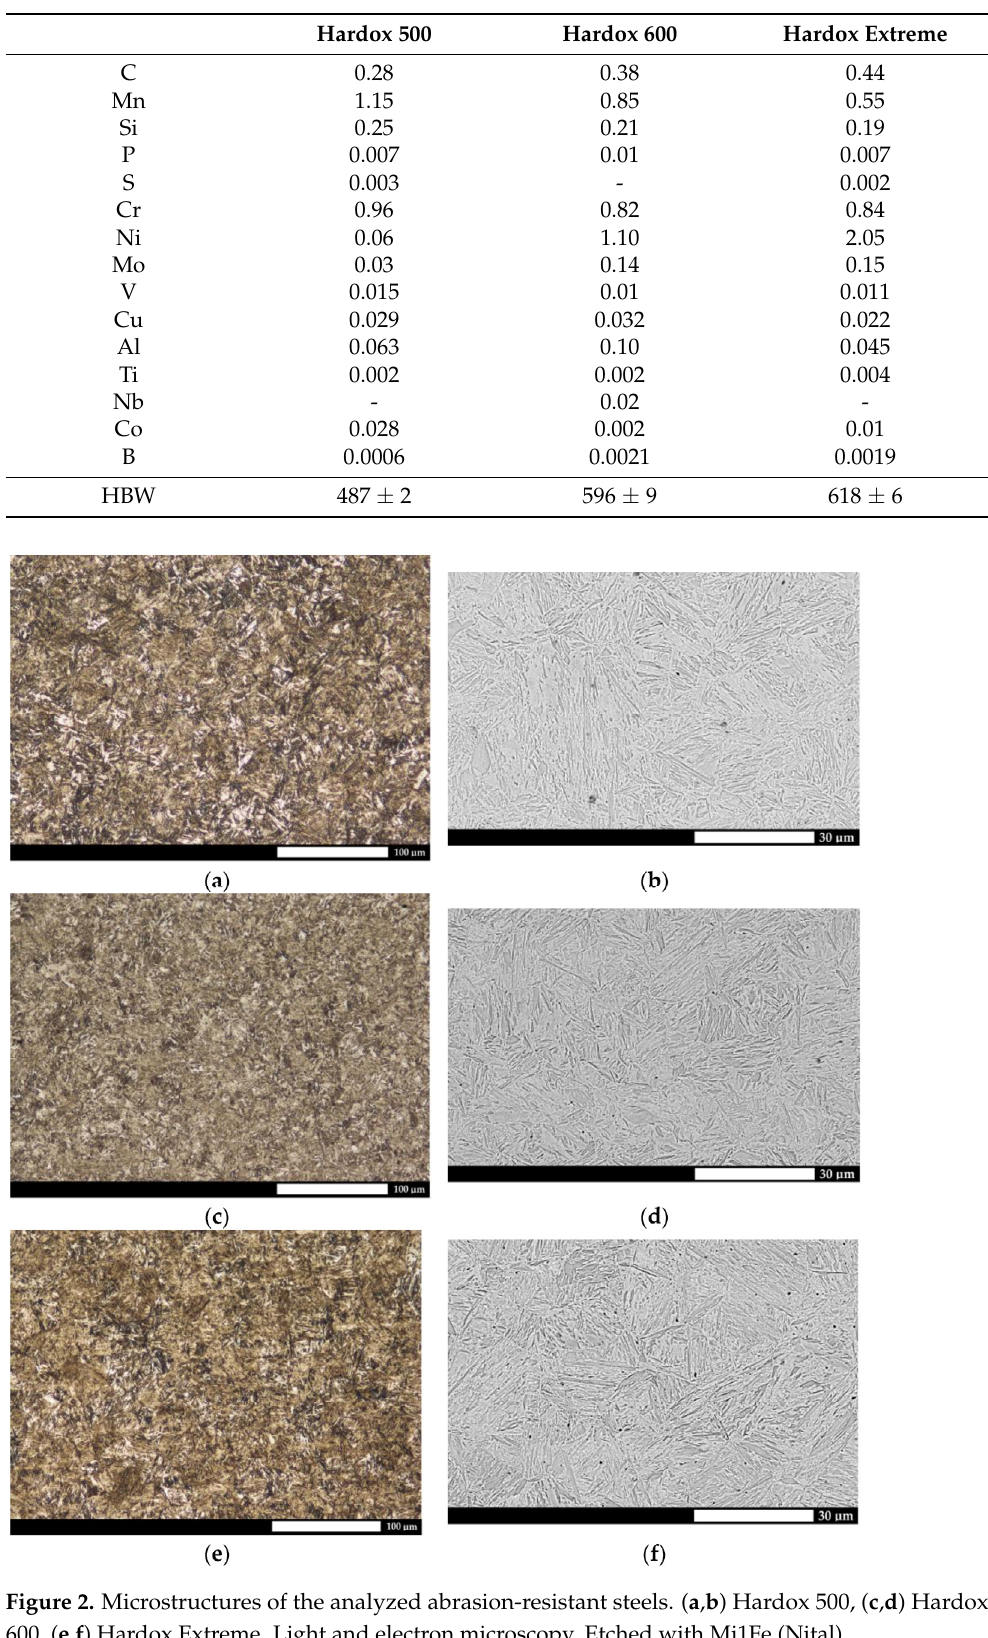
Table 3. Chemical composition and hardness measurement results of the analyzed wear-resistant steels (wt. %).